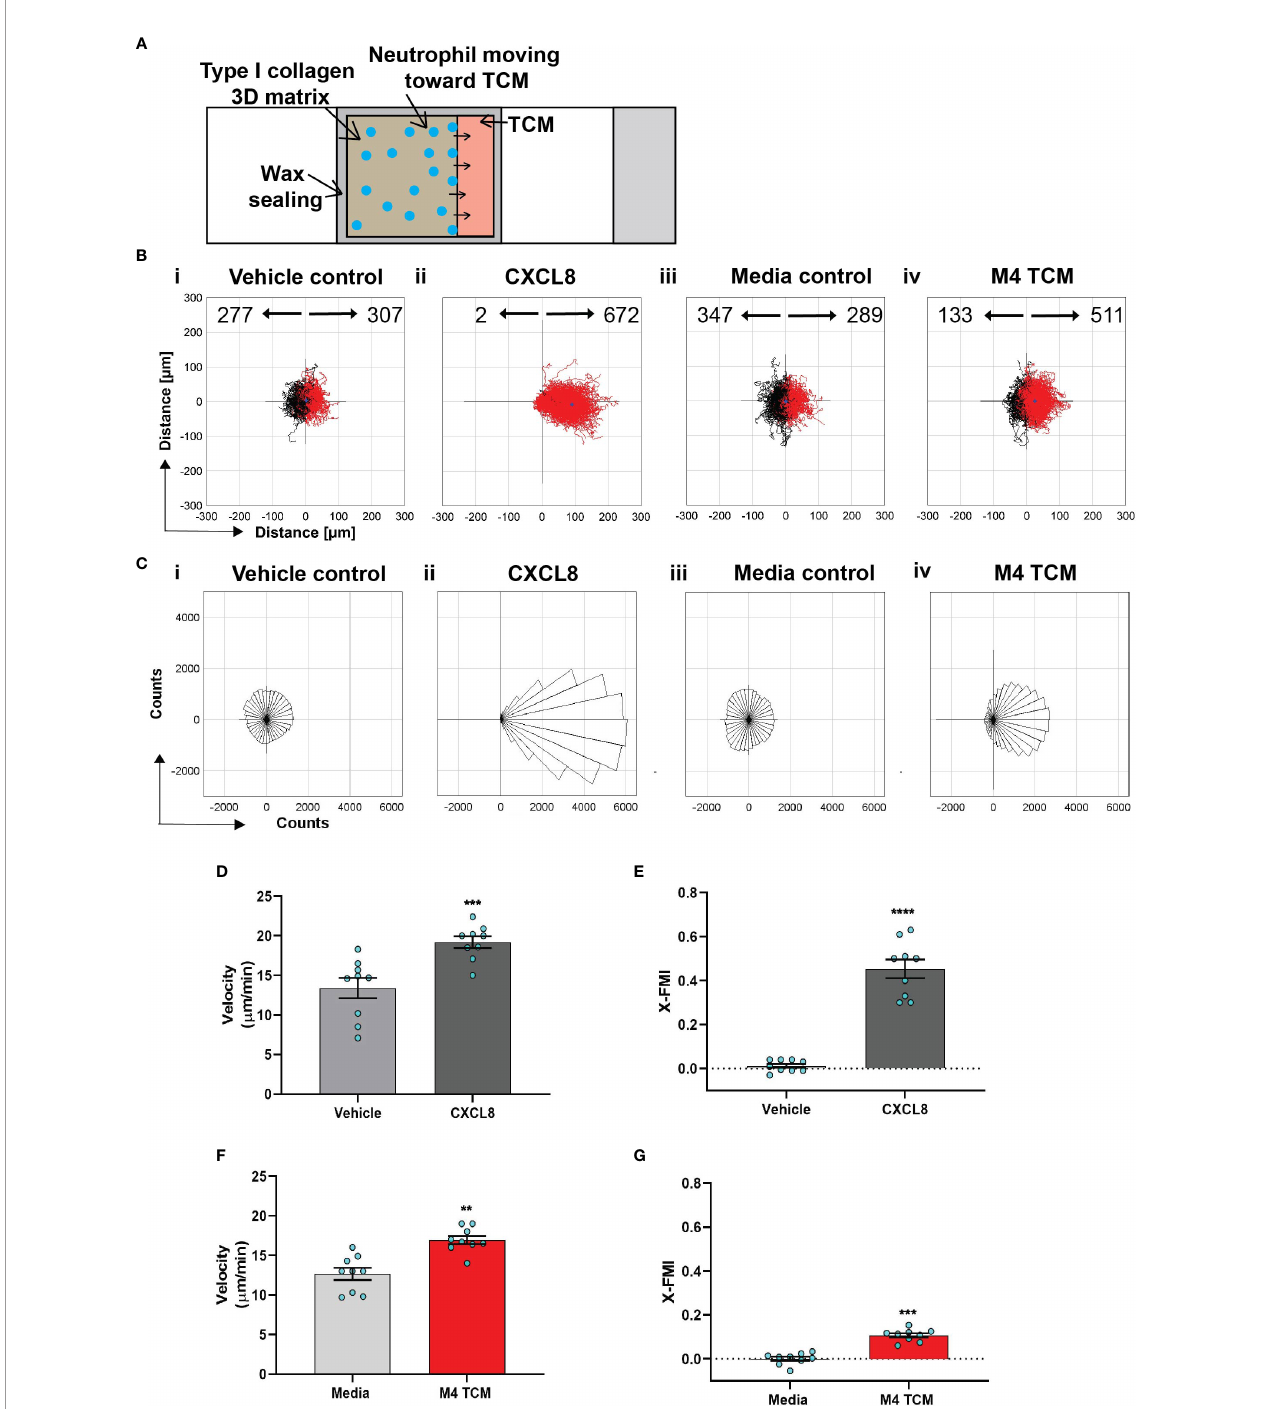
FIGURE 3 | Neutrophils directionally migrate towards secreted factors harvested from TNBC cell line. (A) Cartoon depicting the migration chamber used to assess the chemotaxis of neutrophils in 3D collagen matrix towards TCM. (B, C) Plots showing individual cell tracks (B) and rose plots showing angle histograms of the migrating cells (C) generated from the combined tracks from N=3 independent donors in response to vehicle control (Bi, Ci), 500 nM CXCL8 (Bii, Cii), media control (Biii, Ciii), and M4 TCM (Biv, Civ). Numbers with left and right arrowhead in B represent number of neutrophils moving away and towards different conditions, respectively. (D – G) Graph depicting velocity (D, F) and X-FMI (E, G) of neutrophils migrating towards 500 nM CXCL8 and vehicle control (D, E) or M4 TCM and media (F, G) . Each bar represents mean ± SEM from N=3 independent donors with each dot representing average values from independent positions. ****P < 0.0001, ***P ≤ 0.0005, **P ≤ 0.005 when compared with corresponding control (paired sample